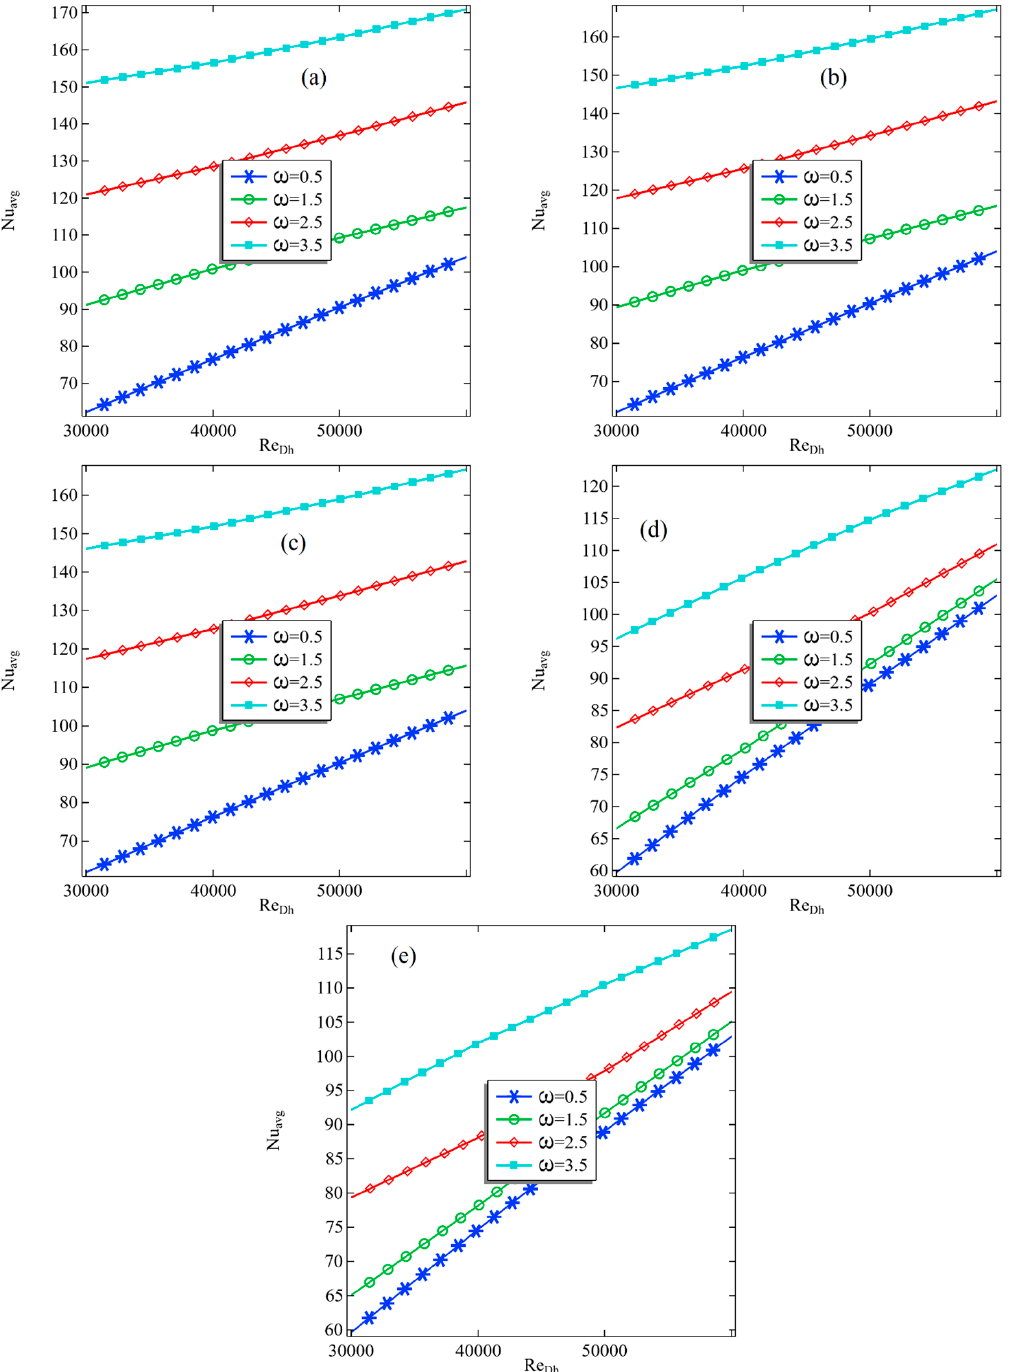
Figure 4. Average Nusselt number at the outlet of the channel with increasing Reynolds number and rotation of cylinders: ( a ) = 0.001; ( b ) = 0.009; ( c ) = 0.01; ( d ) = 0.09; ( e ) = 0.1. Table 4 details the precise impacts of altering the Reynolds number, cylinder rotation, and nanofluid volume fraction.